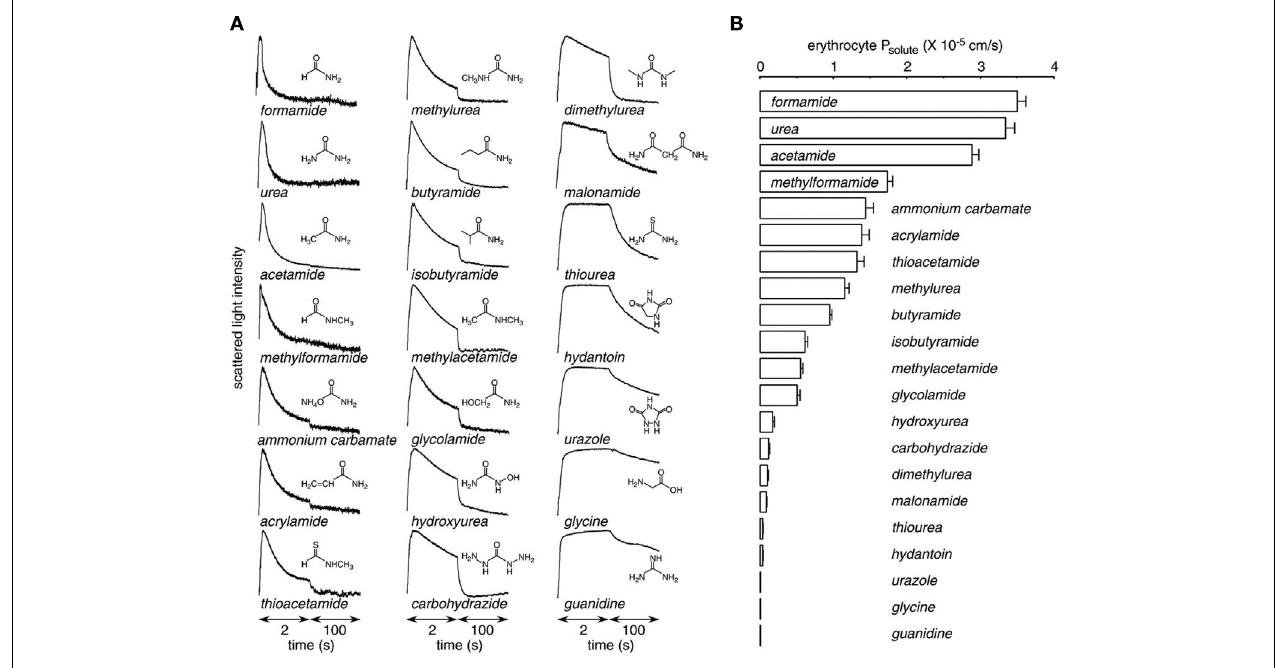
in response to a 250-mM inwardly directed gradient of urea. (B) Averaged solute permeability coefficients (Ps) for experiments done as in panel A (mean ± S.E., n = 3). Reproduced from Zhao et al.